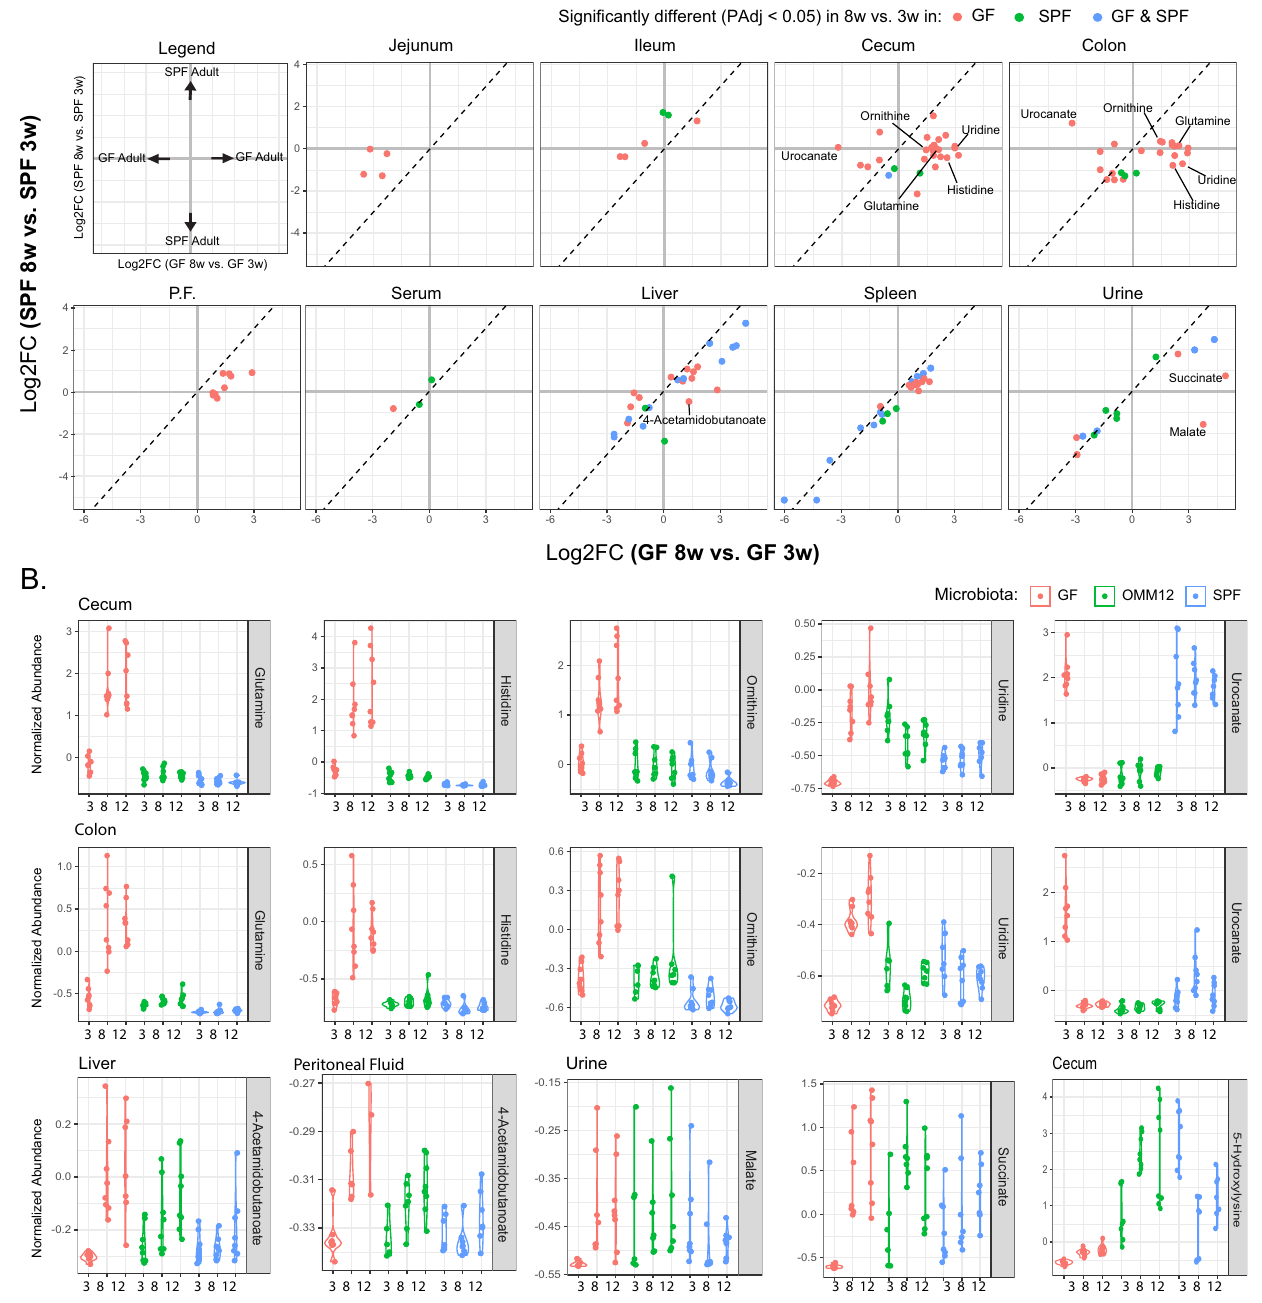
Fig. 4 | Age-speci fi c changes in microbiome-associated metabolism. A Biplot showing the Log2FCinmetabolitesthat were signi fi cantlydifferent (PAdj<0.05)in 3-week-old vs. 8-week-old SPF mice or 3-week-old vs. 8-week-old GF mice. Meta- bolites were signi fi cantly different based on age in GF (red) or SPF (green) or both GF and SPF (blue). B Violin plots of highlighted metabolites from A that are